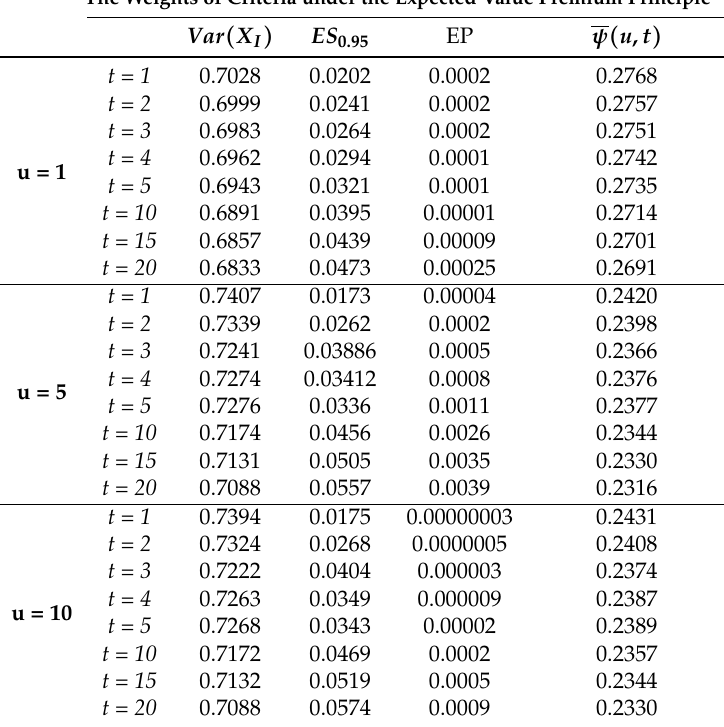
Table 2. The weights of criteria for the entropy method under the expected value premium